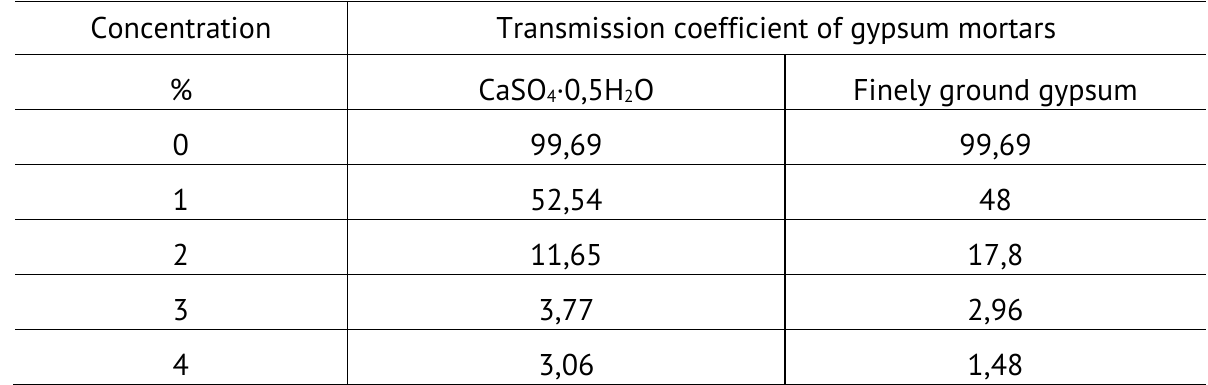
Table 3. Impact of gypsum concentration on the luminous transmission of gypsum mortar